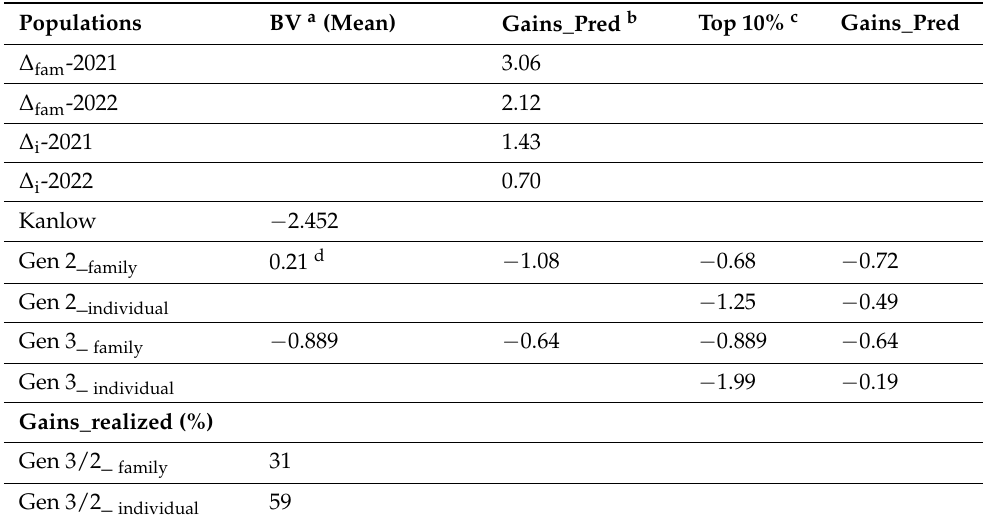
2 fam = 2 i × h f × σ Pf ; R i = i ×